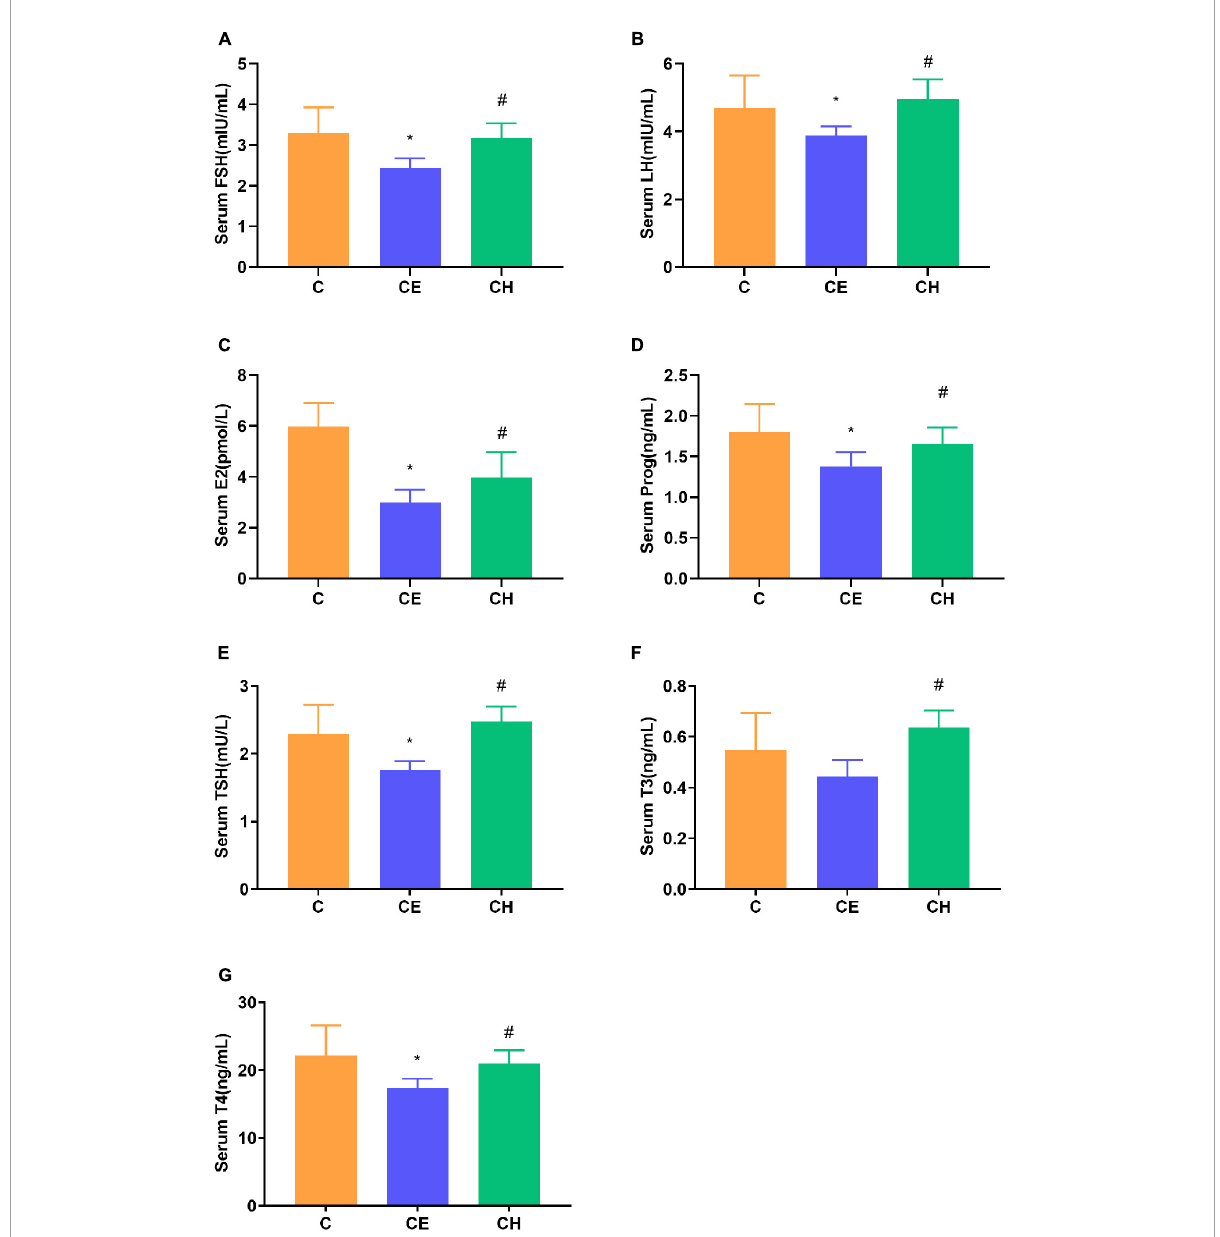
FIGURE3 Alterations of the serum hormone levels. (A) FSH, follicle-stimulating hormone; (B) LH, luteinizing hormone; (C) E 2 , estradiol; (D) Prog, progesterone; (E) TSH, thyroid stimulating hormone; (F) T3, triiodothyronine; (G) T4, thyroxine. Data are represented as the mean ± standard deviation ( n = 8). *Means are significantly different vs. C group (* p < 0.05); # Means are significantly different vs. CE group ( # p < 0.05); C, control group; CE, cold exposure group; CH, Chinese herbs complex